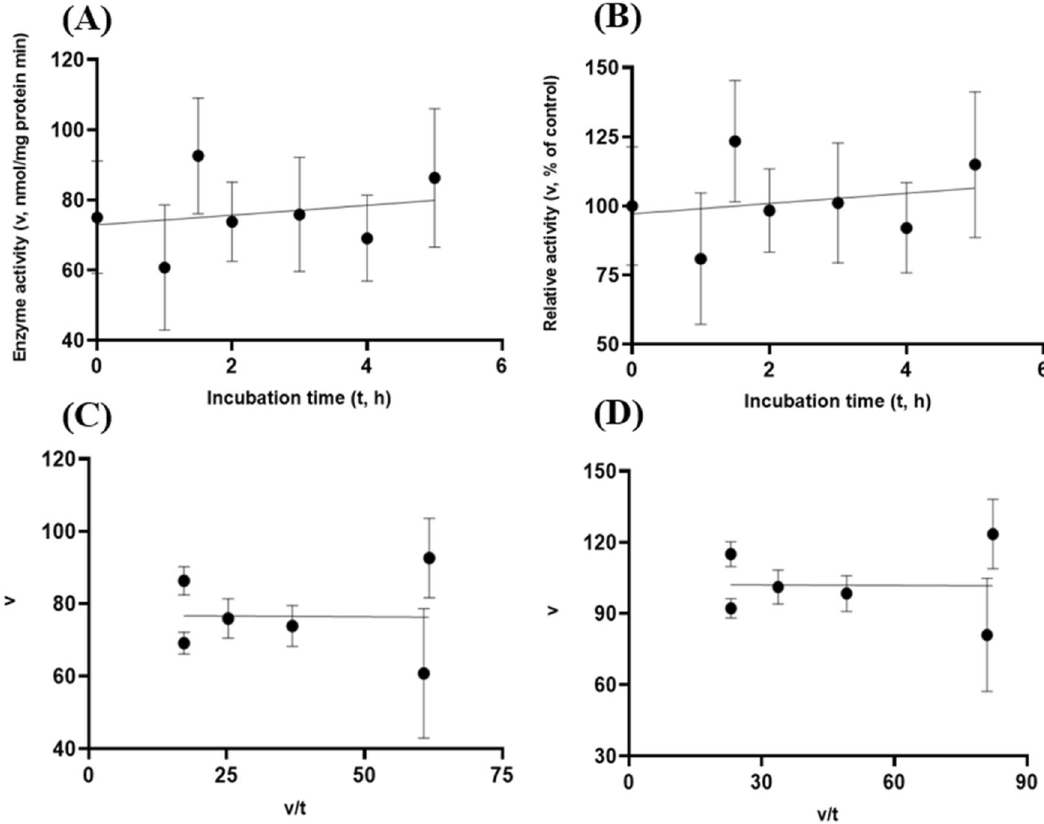
Figure 10. Experiment-2 of the gastric acidic pH and pepsin (274 U/mL) effects (with describing model parameter estimates ± SE ) on heat-treated GH5-tCel5A1 activity over a 5-h period after the gastric pH and pepsin buffer being mixed with the heat-treated crude GH5-tCel5A1 enzyme preparation for incubation at the resulting mixture pH = 3.5 and pepsin at 274 U/mL prior to further incubation for measuring cellulase activity with the carboxymethyl cellulose (CMC) substrate buffer in presence of dithiothreitol (DTT) (5 mM) and N 2 gas purging for 15 min at 37 °C. (A) Exponential plot of the inhibition kinetic relationship between the heat- treated GH5-tCel5A1 activity (v, mean ± SE, n = 12at each time point, nmol/mg protein•min) and incubation time (t, h) under the gastric pH 3.5 and pepsin (274 U/mL) conditions established according to the exponential response model as: Y = 73.926 ( ± 10.537 ) e ( − x ) , P < 0.0001 for the initial residual heat-treated tCel5A1 activity estimate; and P = 0.764 for the rate constant estimate; R 2 = 0.024 , n = 84; and alternatively, established according to the linear response model as y = 73.947 ( ± 10.717 ) + 1.100 ( ± 3.725 ) x , P < 0.0001 for the intercept; and P = 0.769 for the slope, r 2 = 0.024 , n = 84; (B) Exponential plot of the inhibition kinetic relationship between the relative heat treated GH5-tCel5A1 activity (v, mean ± SE, n = 12at each time point, % of the control group measured at I C of 100.000 ± 21.379 at the 0-min exposure to the gastric pH-3.5 and pepsin-274 U/mL incubation) and incubation time under gastric pH 3.5 and pepsin (274 U/mL) conditions according to the exponential response model established as: Y = 104.600 ( ± 14.337 ) e ( − x ) , P < 0.0001 for the initial residual heat treated GH5-tCel5A1 activity estimate; and P = 0.994 for the rate constant estimate, R 2 = 0.026 , n = 84; and according to the linear response model established as y = 104.600 ( ± 14.343 ) + 0.0391 ( ± 4.932 ) x , P < 0.0001 for the intercept and P = 0.994 for the slope, r 2 = 0.026 , n = 84; (C ) the Eadie-Hofstee linear plot between the heat- treated tCel5A1 enzyme activity (v, mean ± SE, n = 12at each data point, nmol/mg protein•min) and the v/t ratio established as y = 38.483 ( ± 6.445 ) + 1.053 ( ± 0.124 ) x , P < 0.0001 for all parameter estimates; r 2 = 0.524 , n = 72; and (D ) the Eadie-Hofstee linear plot between the relative heat-treated GH5-tCel5A1 enzyme activity (v, mean ± SE, n = 12at each data point, % of the control group measured at I C of 100.000 ± 21.379) at the 0-min exposure to the gastric pH-3.5 and pepsin-274 U/mL incubation) and the v/t ratio established as y = 51.280 ( ± 8.588 ) + 1.053 ( ± 0.124 ) x , P < 0.0001 for all parameter estimates; r 2 = 0.524 , n =